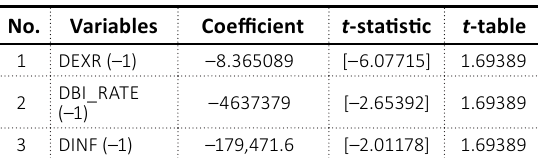
Table 5. Long-term VECM